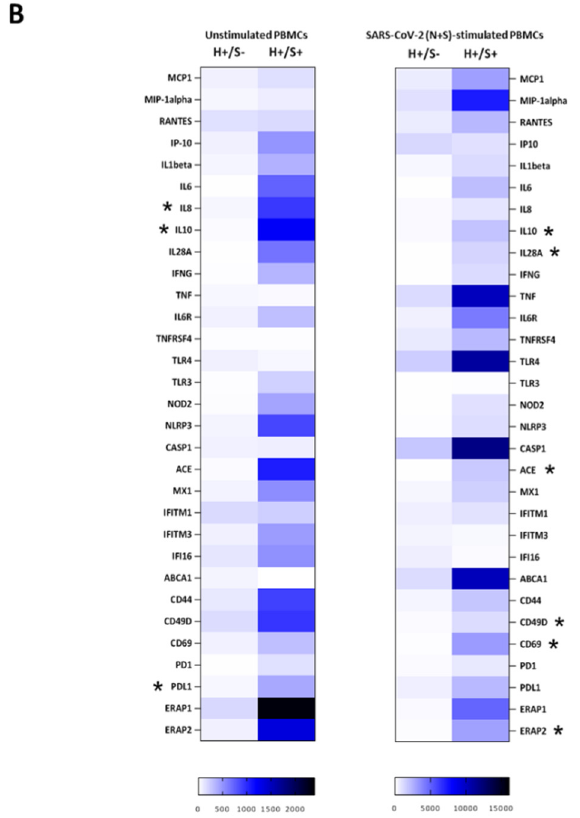
Figure 1. Immunological responses in H+/S − vs. H+/S+ individuals. ( A ) Plasma cytokine/chemokine concentrations (pg/mL) in H+/S − (grey bars) and H+/S+ (black bars) patients; ( B ) mRNA expression of genes involved in the antimicrobial immune response in unstimulated (left panel) and SARS-CoV-2 (N+S)-stimulated (right panel) PBMCs isolated from H+/S − and H+/S+ individuals; gene expression (mean values) is shown as a color scale from white to blue/black (Heatmap). Results are indicated as mean ± SEM values and statistically significant differences ( p < 0.05) are indicated; * p < 0.05.